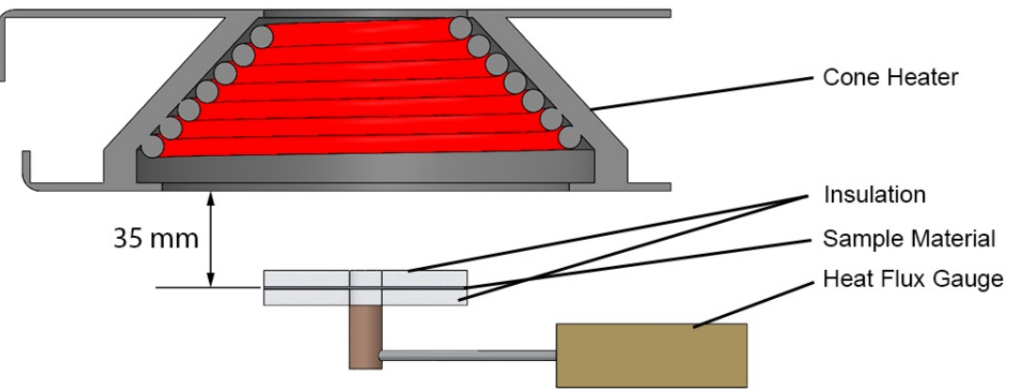
Figure 3. Rendering of the method used to measure absorption coefficient.